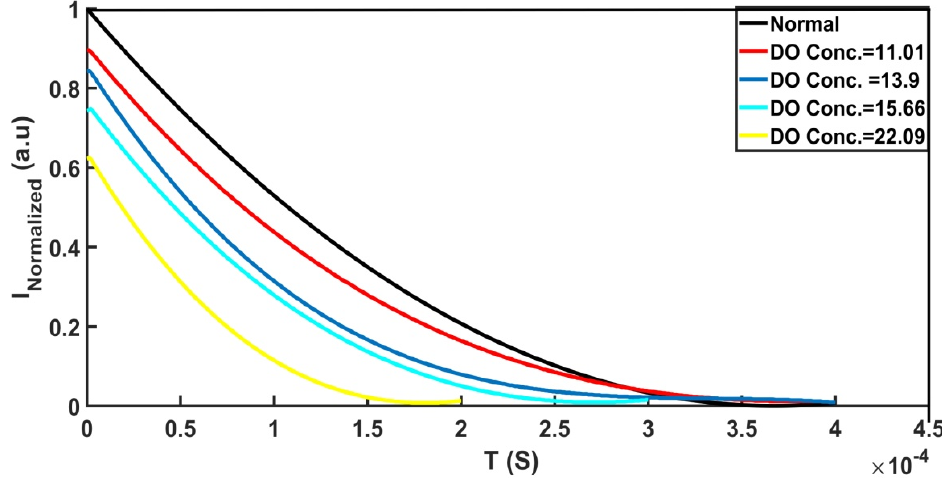
Figure 6. Intensity decay versus time of gold–ceria nanoparticles at different DO concentrations (in mg/L).